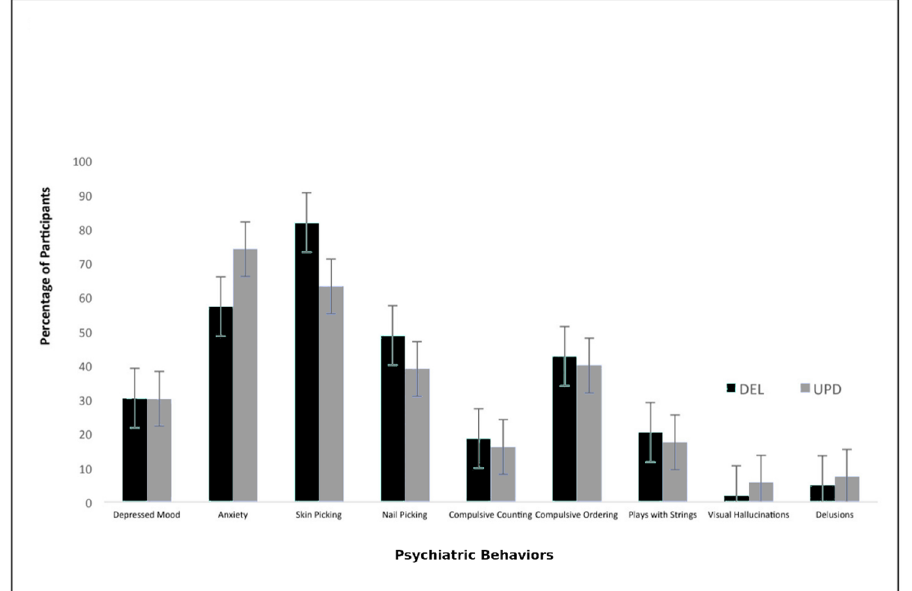
Figure 4. Prader-Willi syndrome (PWS) genetic subtype–phenotype associations (DEL = deletion; UPD = uniparental disomy). Comparison between individuals with DEL and UPD for nine psychiatric phenotypes.